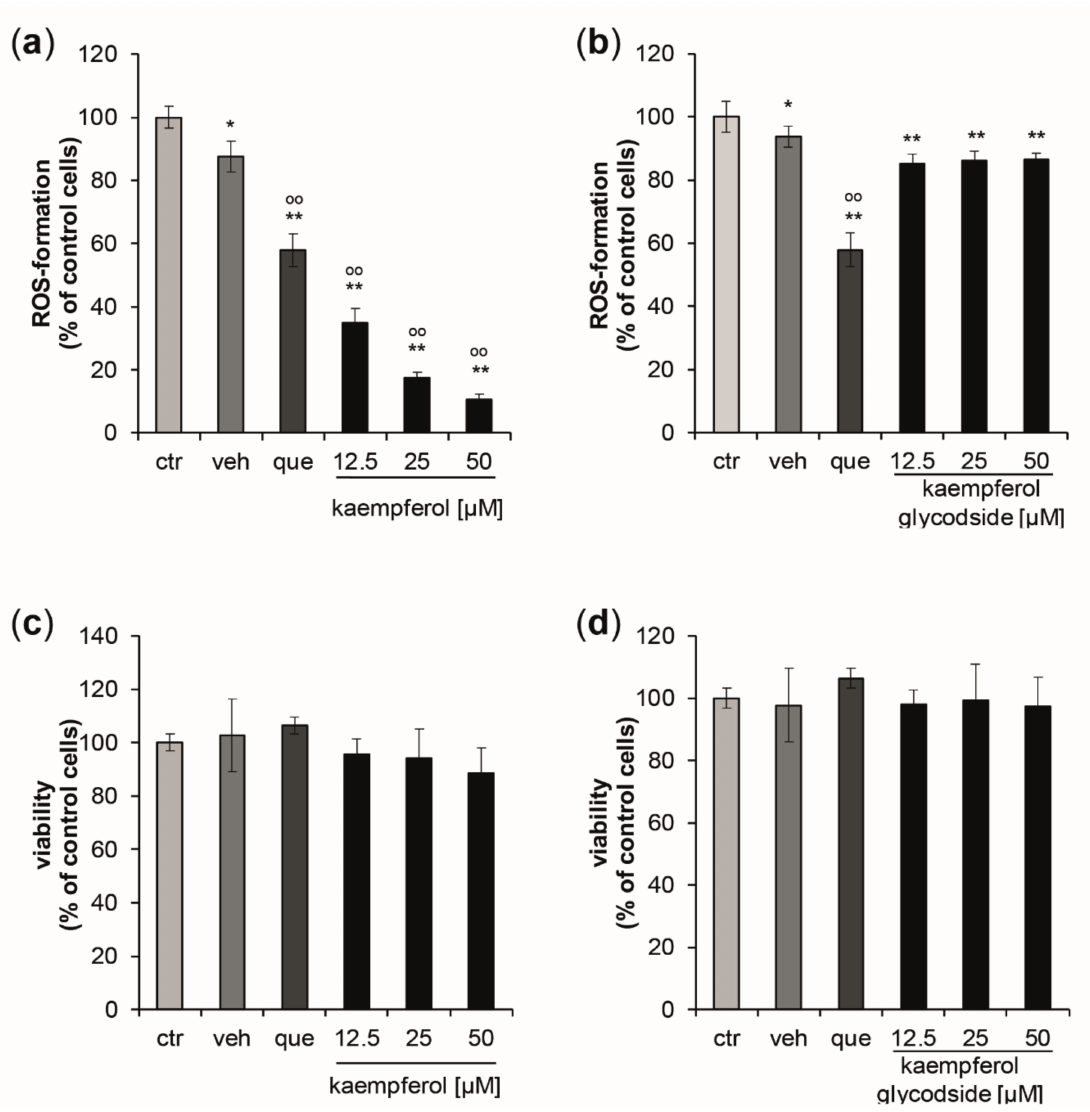
Figure 1. ( a , b ) Inhibition of peroxyl-radical-induced reactive oxygen species (ROS)-formation induced by AAPH stimulation in HaCaT keratinocytes pretreated with either quercetin [10 µ M] (que) as a positive control, with increasing concentrations of kaempferol, kaempferol glycoside, or with bu ff er (ctr) or vehicle (veh). ROS formation was calculated as mean percentages of dichlorofluorescein fluorescence, the signal of the cells treated with the radical generator only (ctr = control) was set to 100%. ( c , d ) E ff ects of increasing concentrations of kaempferol and kaempferol glycoside treatment on cell viability measured 24 h after the treatment. Data were normalized to the control cells (ctr), which were treated with bu ff er only. (Mean values ± S.E.M., n = 4, * p < 0.05, ** p < 0.005 compared to ctr, ◦ p < 0.05, ◦◦ p < 0.005 compared to